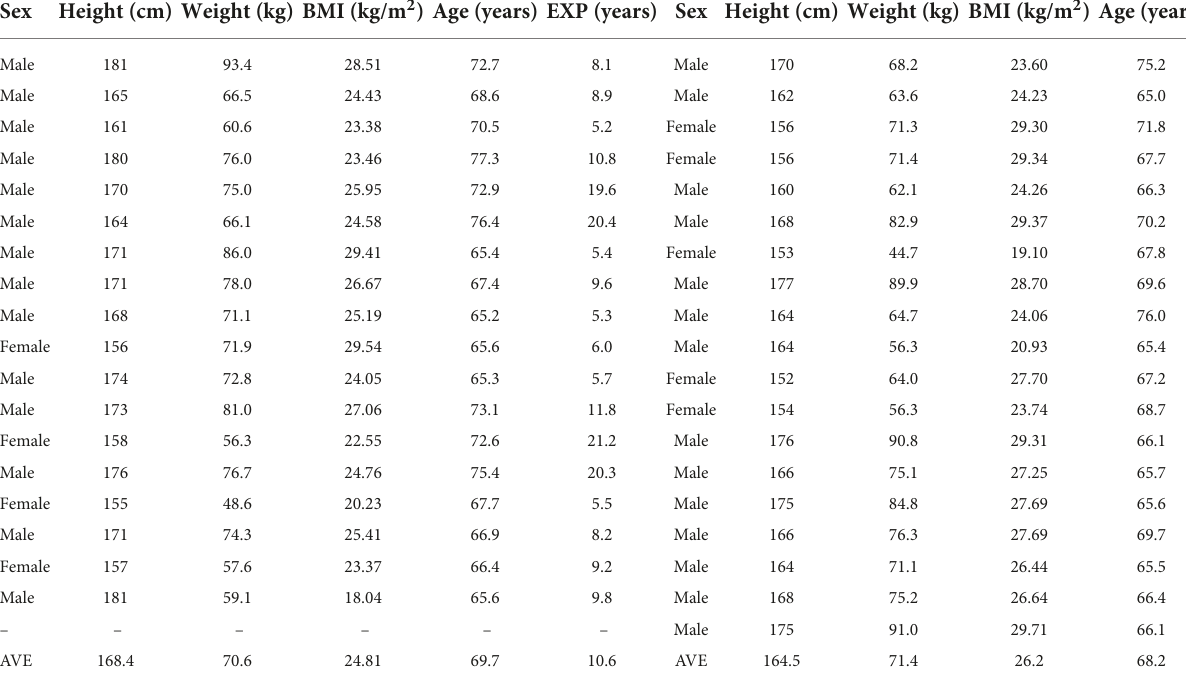
TABLE 1 Basic information of the participants in Tai Chi and control groups. Tai Chi